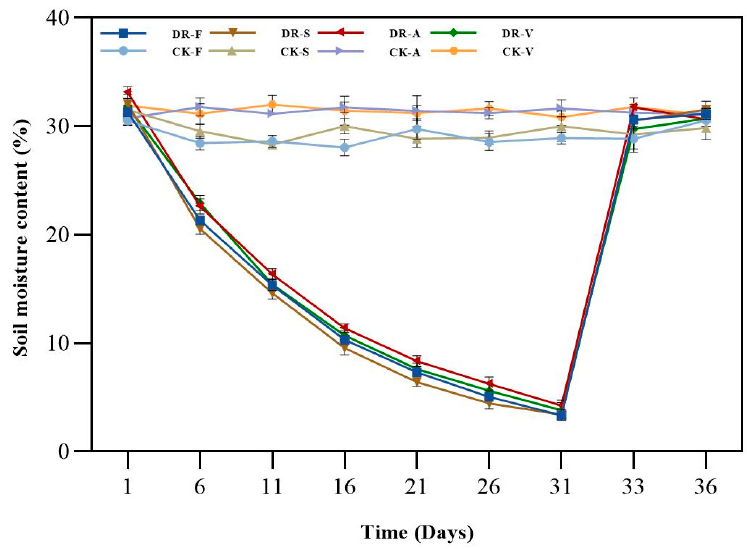
Figure 1. Effects of drought stress and rewatering on soil moisture content of four oak species (DR-F: drought-rewatering sample of Q. fabri ; CK-F: well watered sample of Q. fabri ; DR-S: drought-rewatering sample of Q. serrata ; CK-S: well watered sample of Q. serrata ; DR-A: drought-rewatering sample of Q. acutissima ; CK-A: well watered sample of Q. acutissima ; DR-V: drought-rewatering sample of Q. variabilis ; CK-V: well watered sample of Q. variabilis ).